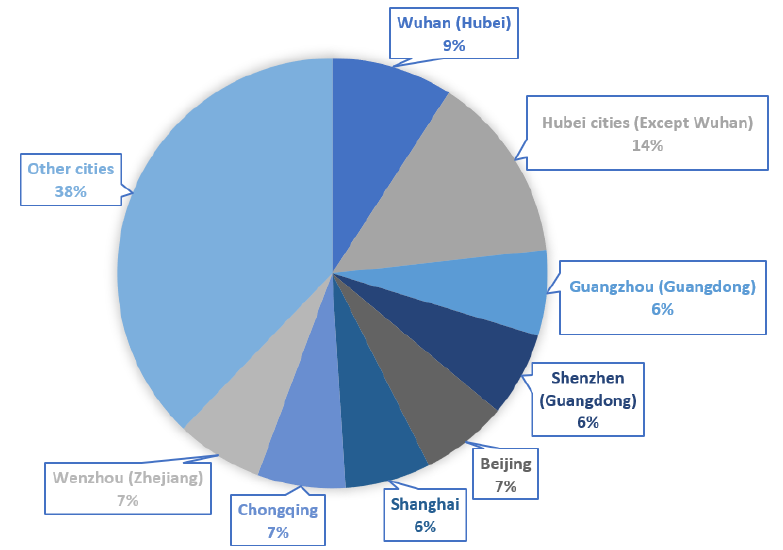
Figure 3. Geographic distribution of the samples.